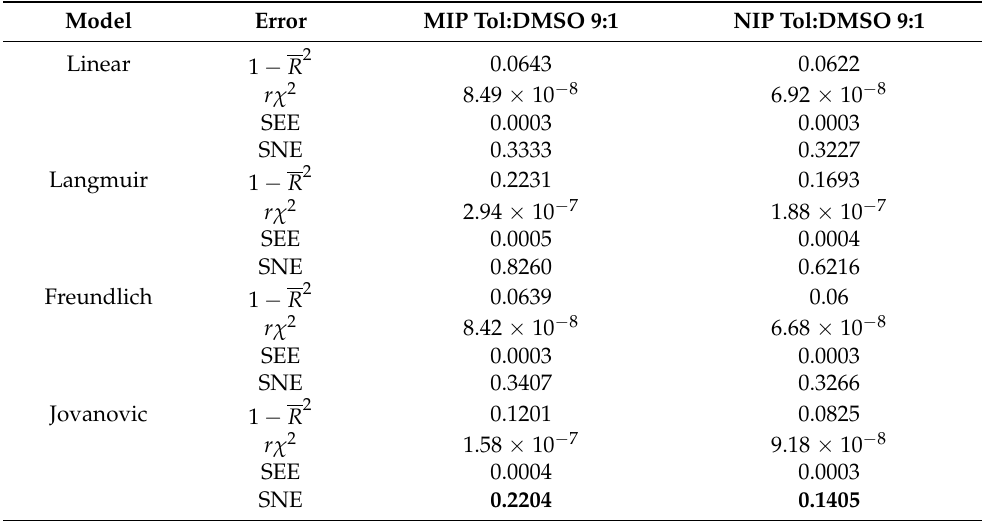
Table 5. The errors of the adsorption